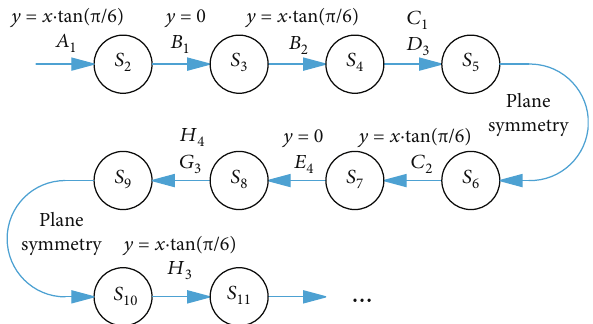
Figure 12: Calculation process of the coordinates of the circle center of a typical envelope